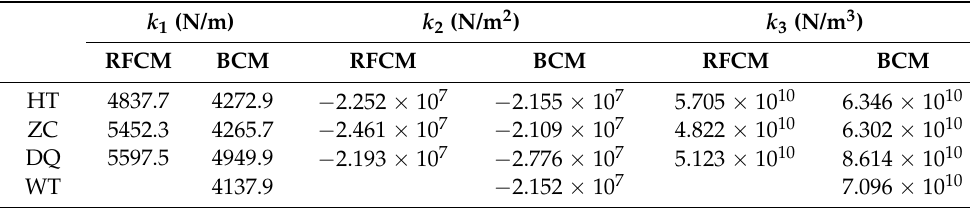
Table 3. Estimated stiffness parameters of the experimental system.